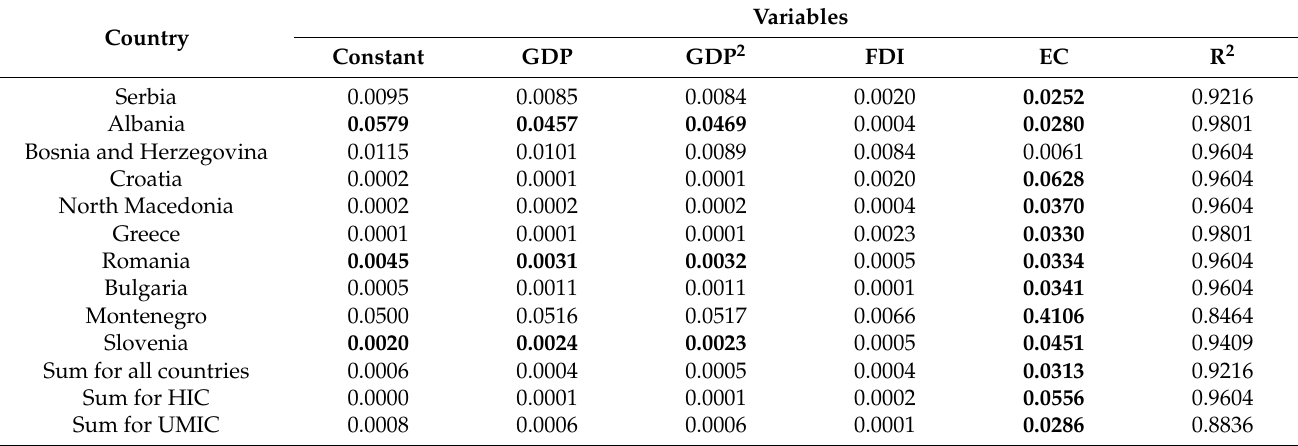
Table 7. Multivariate linear regression fit